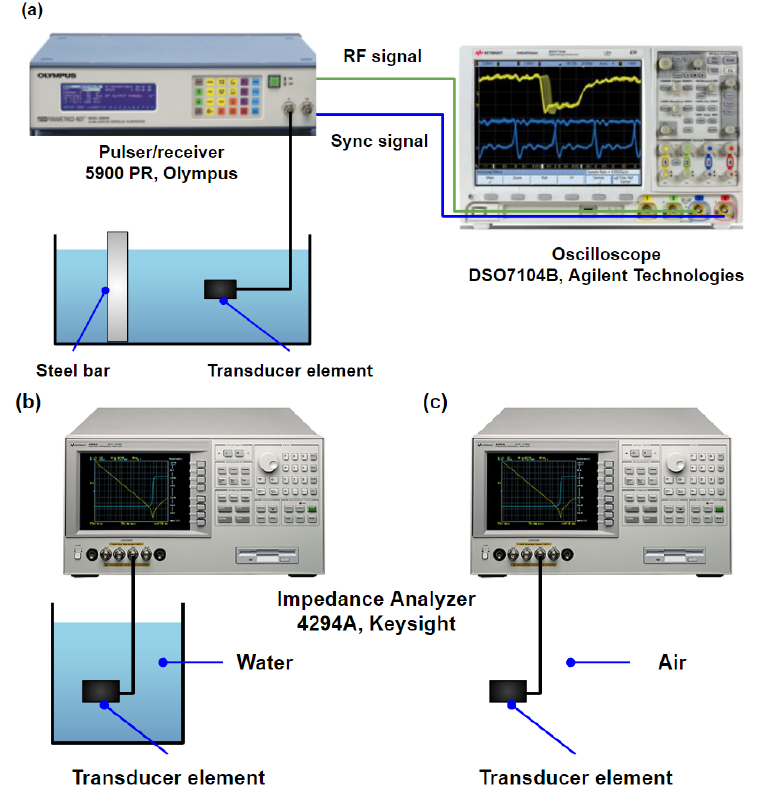
Figure 4. Schematics of the experimental setups for transducer characterizations: ( a ) pulse/echo test for the transducer; electrical impedance measurements for the transducer element in ( b ) water and in ( c )